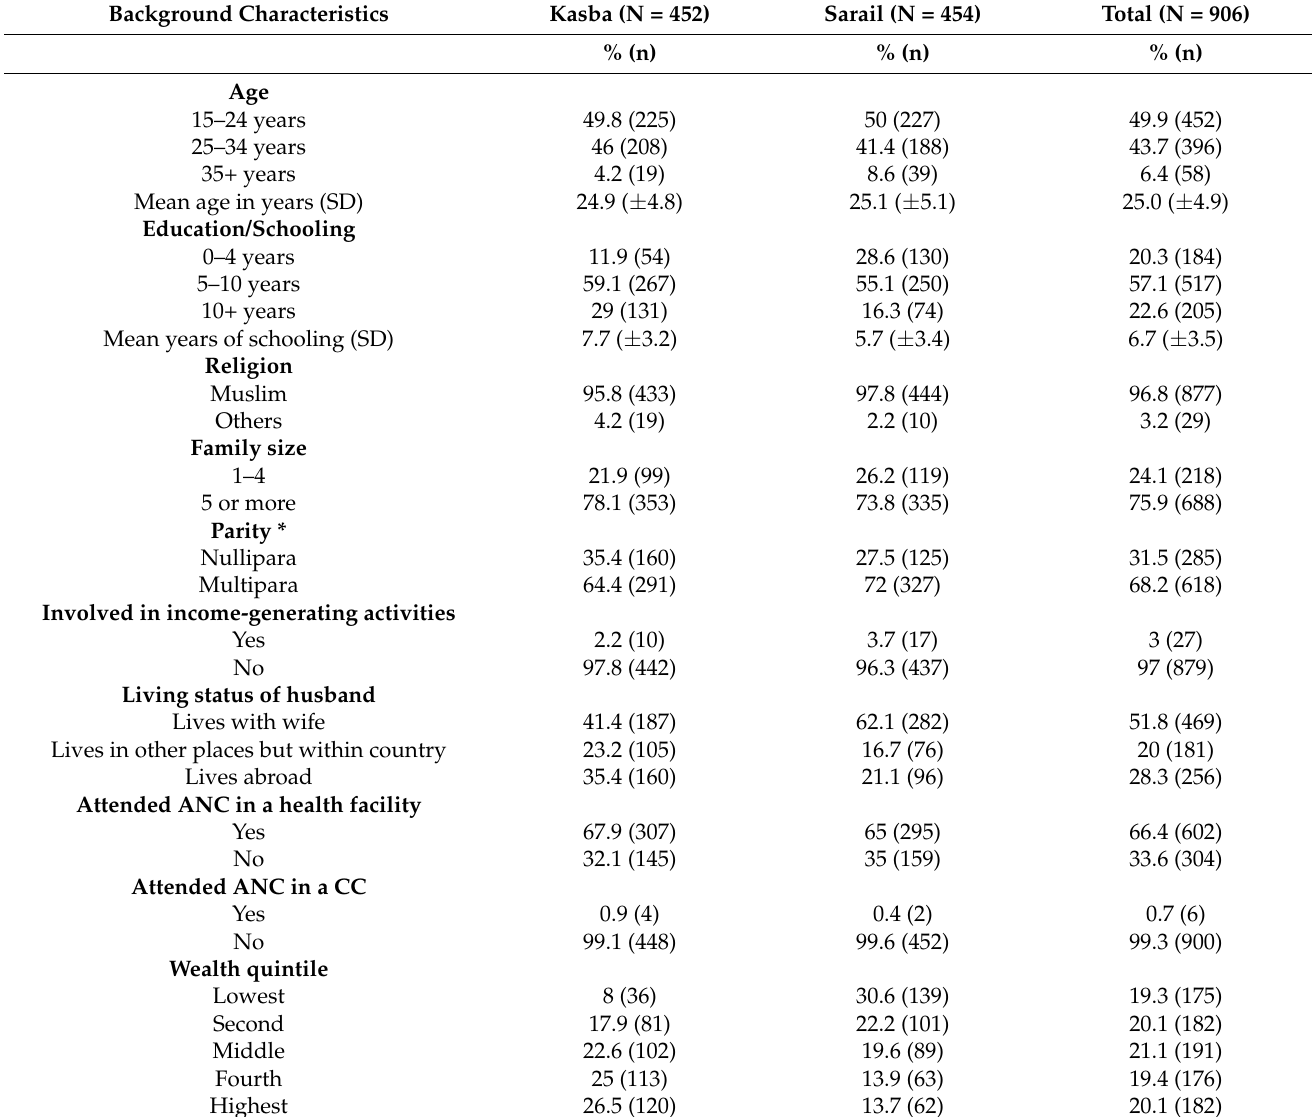
Table 1. Background characteristics of respondents (Kasba = 452 and Sarail =